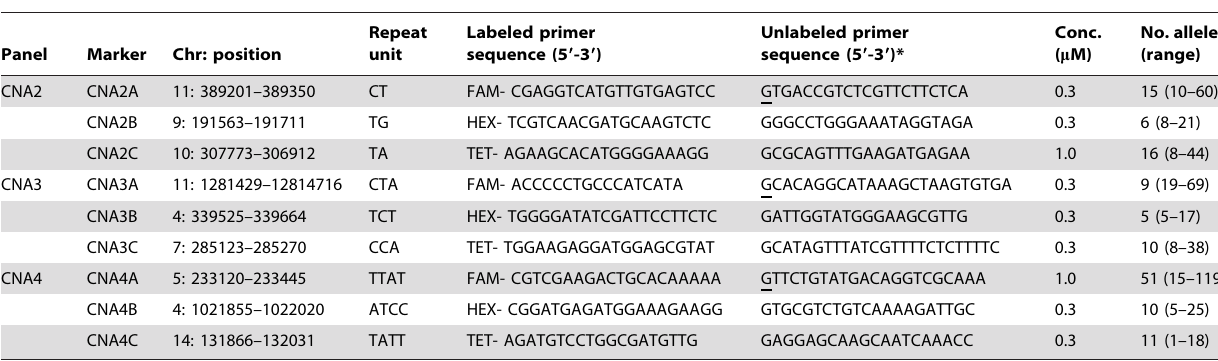
Table 1. Basic characteristics of the selected microsatellite markers.